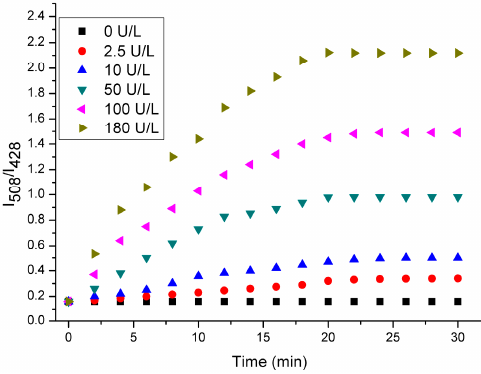
Figure 2. Time-dependent fluorescent spectra of probe 1 (10 μ M) in in the presence of different amounts of ALP in Tris-HCl buffer solution (pH 7.4, 10 mM) with 1% DMSO.